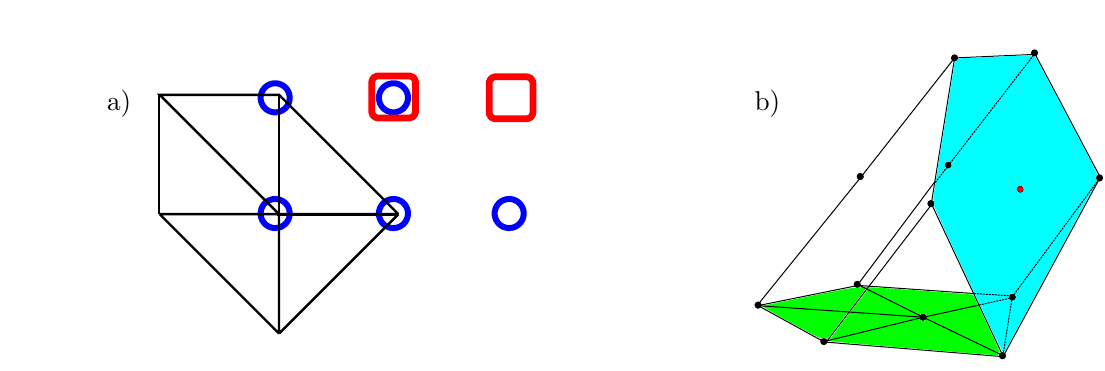
Figure 17 . Two depictions of the polytope ( F 5 , top 3) that has SCPs. A projection of the top is depicted in a) with vertices at height one in blue and those at height two in red. The vertex at (1,0,1) lies in a face of the top. This face is shaded in blue in (cid:12)gure b) where the interior vertex is marked in